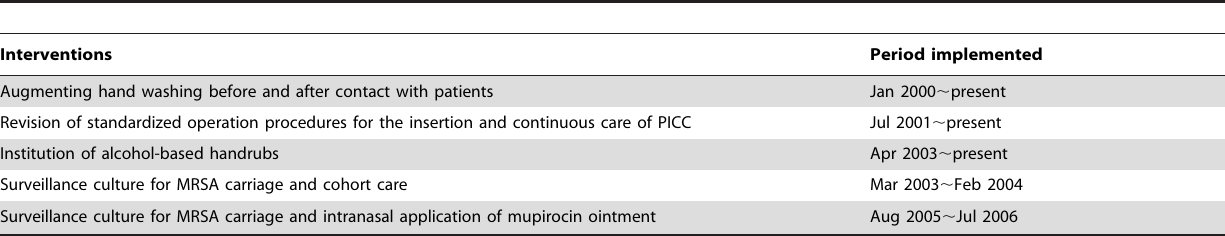
Table 1. Infection control measures implemented in the neonatal intensive care units of Chang Gung Children’s Hospital between 1999 and